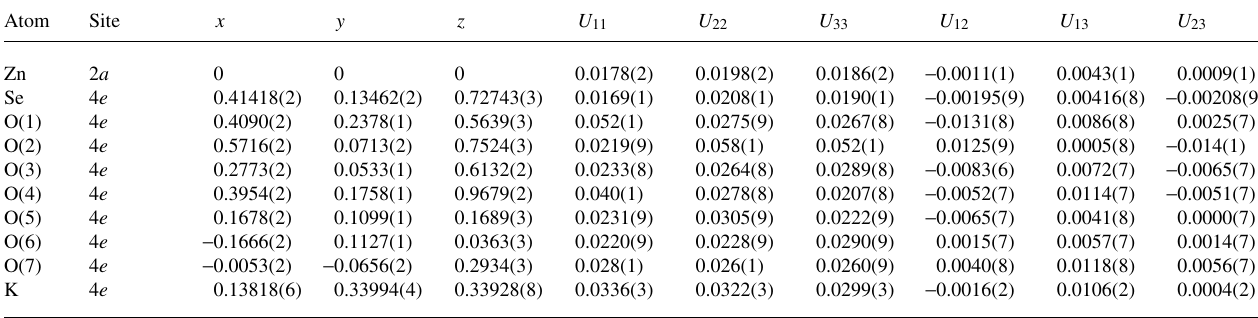
Table 12. Atomic coordinates and displacement parameters (in Å 2 )